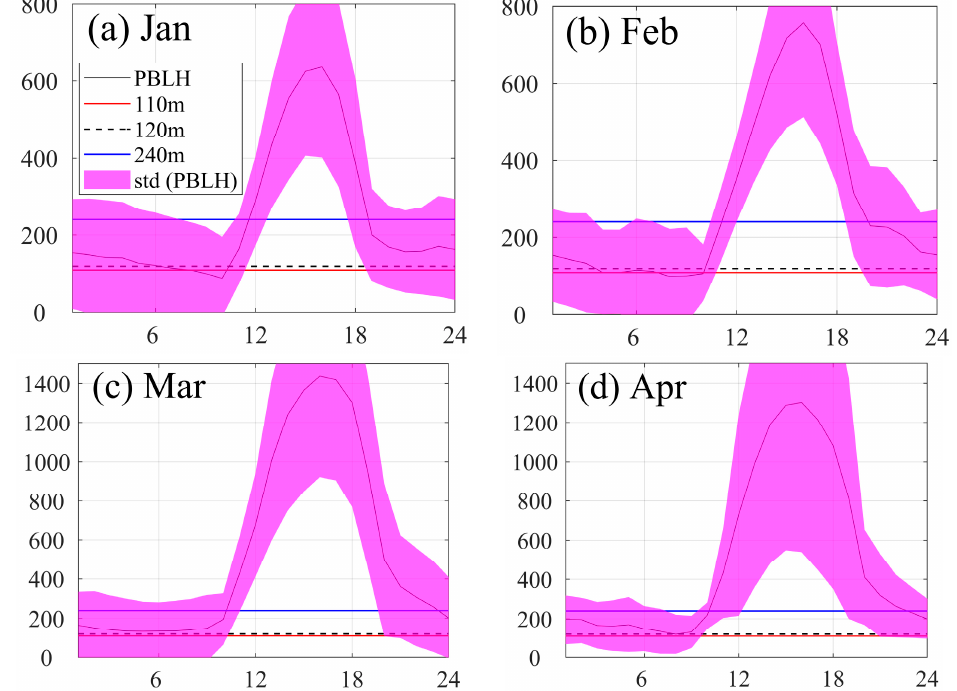
Figure 7. Monthly averaged diurnal variations of PBLH in ( a ) January, ( b ) February, ( c ) March, and ( d ) April. The shade is standard deviation for PBLH.